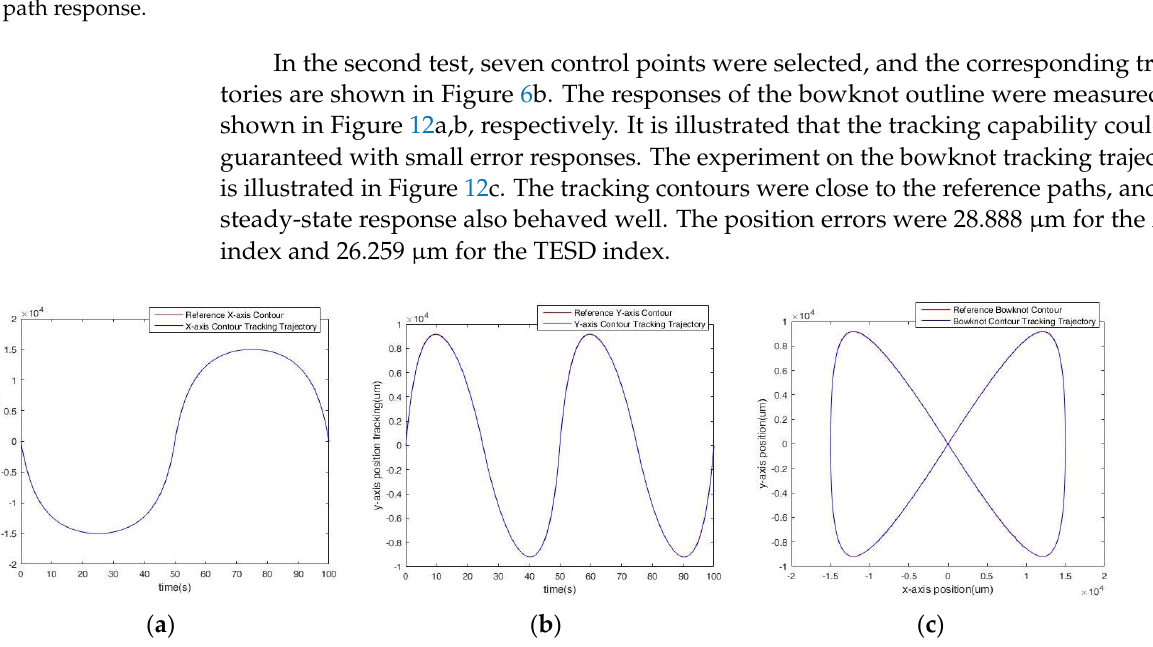
Figure 12. The path trajectory of the experiments. ( a ) The X − axis tracking response, ( b ) the Y − axis tracking response, ( c ) the bowknot path response.